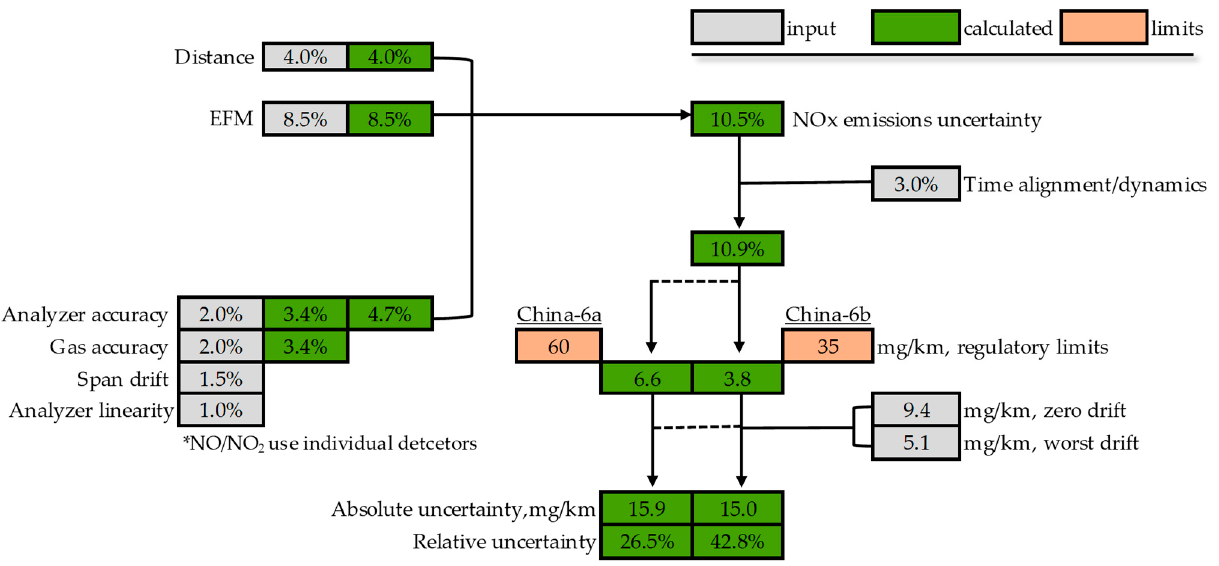
Figure 8. PEMS absolute uncertainty results estimated for China-6a and China-6b limits.